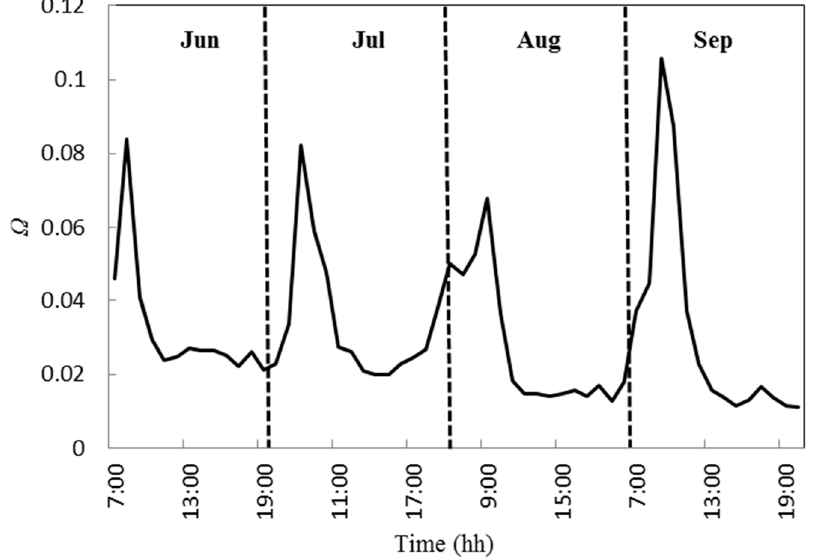
Figure 6. Decoupling coefficient ( Ω ) for the Populus euphratica forest during the growing season in 2014. The values in the figure are averages of Ω at the same hour on different observational days in each month.